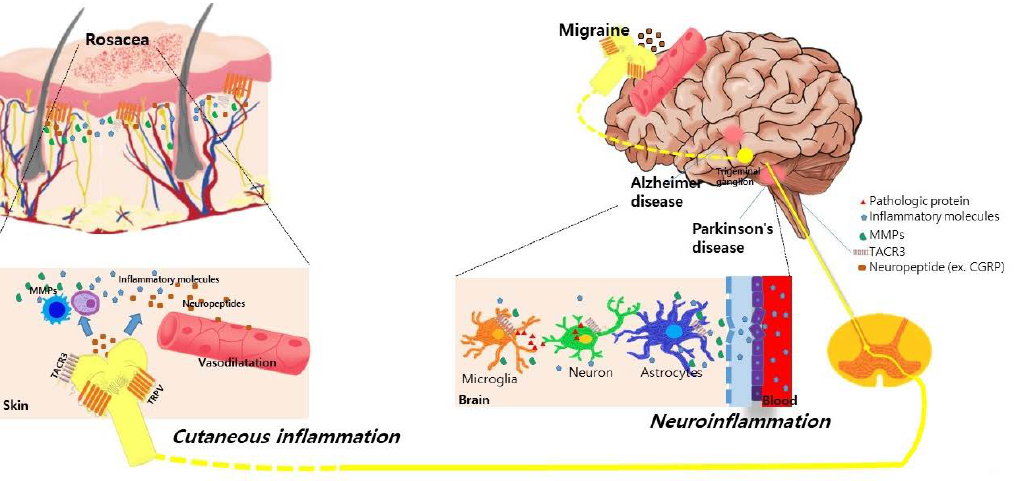
Figure 1. Proposed common underlying mechanisms between rosacea and various neurological disorders. Activation of transient receptor potential vanilloid type 1 (TRPV) receptors in neuronal tissues and skin induces the release of neuropeptides such as calcitonin gene-related peptide (CGRP) and substance P in patients with rosacea and migraine. These neuropeptides induce the vasodilation of cutaneous blood vessels and degranulation of mast cells, further stimulating the release of inflammatory molecules and matrix metalloproteinases (MMPs) in rosacea. In Parkinson’s disease and Alzheimer’s disease, the increased expression of MMPs is also observed in the neural tissue, cerebrospinal fluid, and serum of patients, which disrupts the blood–brain barrier and further induces neuroinflammation. Genetic polymorphisms in the TACR3 gene are found in patients with rosacea and Parkinson’s disease. This shared pathogenic link might synergistically influence the association between neurologic disorders and rosacea.